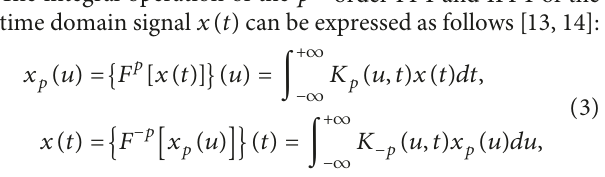
Figure 2: OFDM-LFM unified system measurement, control, and communication system framework based on the